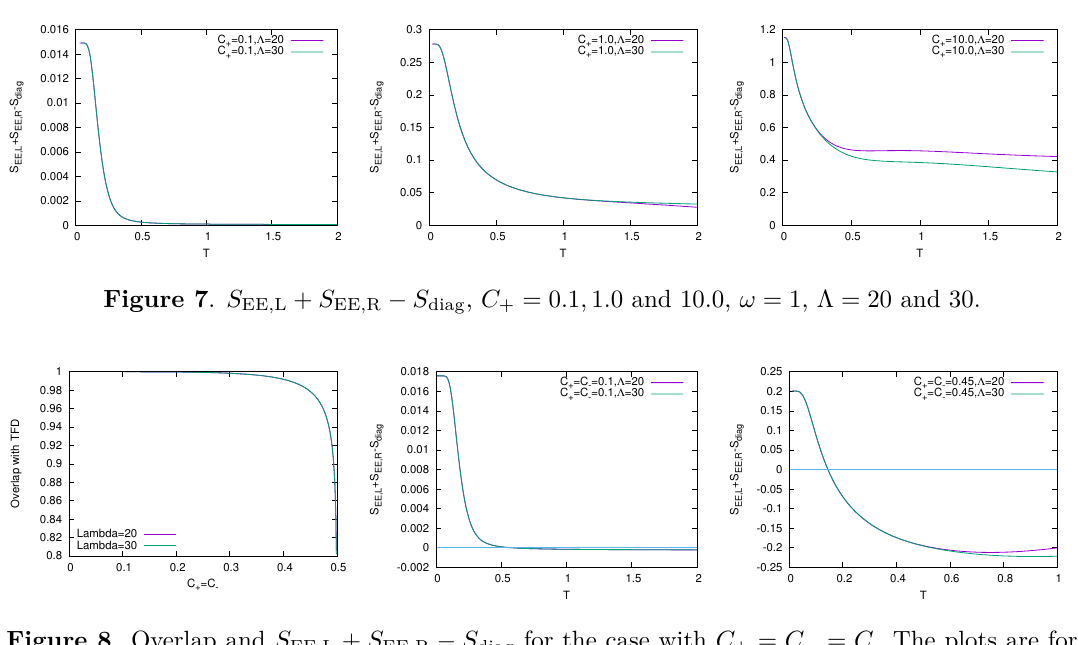
Figure 8 . Overlap and S EE , L + S EE , R − S diag for the case with C + = C − = C . The plots are for C = 0 . 1 and 0 . 45 respectively where ω = 1 and Λ = 20 and 30 for each choice of C